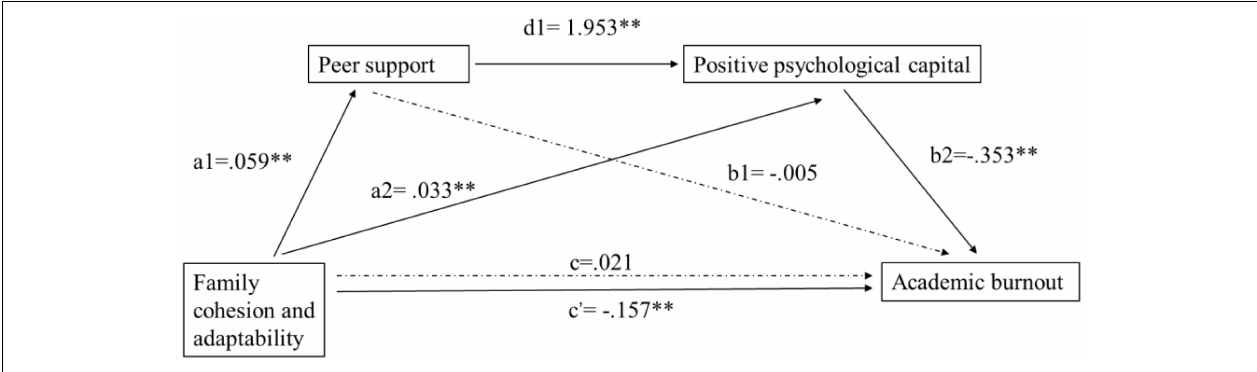
FIGURE 2 | The serial mediation role of peer support and positive psychological capital in the relationship between family cohesion and adaptability and academic burnout and unstandardized beta values. c and c’ represent the direct effect and indirect effect of family cohesion and adaptability on academic burnout, respectively. ∗∗ p <